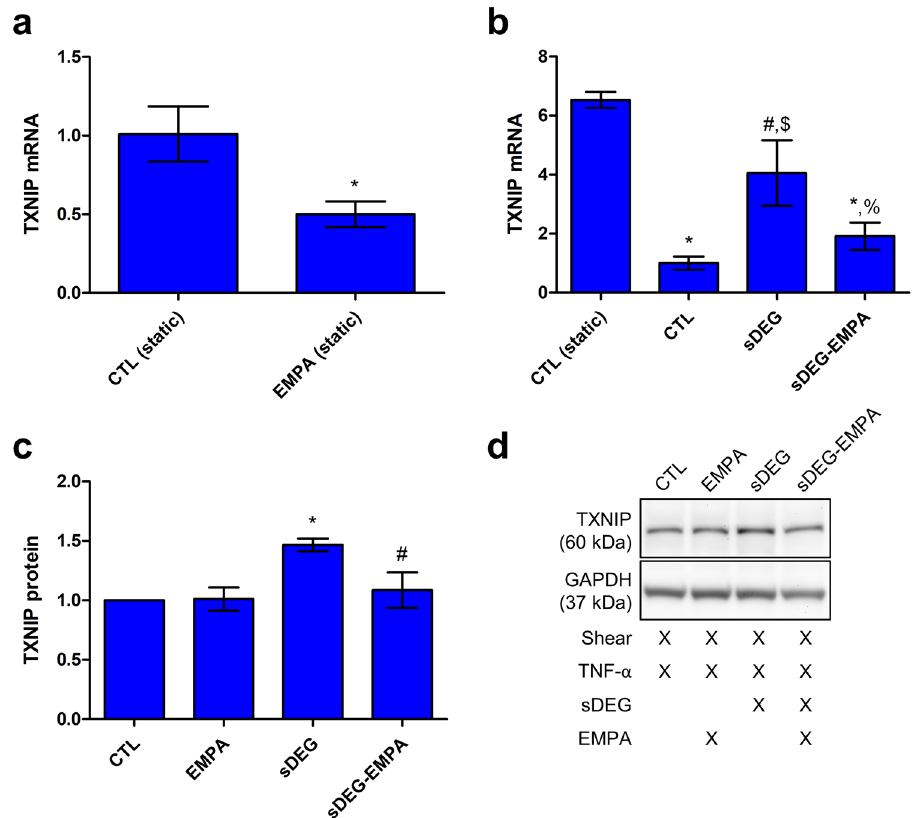
Figure 4. TXNIP mRNA expression from transcriptome analysis and protein expression in static and shear culture. ( a ) EMPA significantly reduced TXNIP mRNA levels after 6 h of static culture (EMPA vs CTL *p < 0.05) (conditions in triplicates). ( b ) TXNIP mRNA level is differently regulated by shear, sustained HS degradation and EMPA after 24 h. Shear downregulated TXNIP mRNA compared to the static control (CTL vs CTL (Static) *p < 0.001) while sustained degradation partly abolished shear-induced downregulation (sDEG vs CTL # p < 0.01, sDEG vs CTL (Static) $ p < 0.01) in TNF-α stimulated ECs. EMPA treatment restored the shear-induced downregulation compared to sDEG (sDEG-EMPA vs sDEG % p < 0.05, sDEG-EMPA vs CTL (Static) *p < 0.001) (conditions in triplicates). ( c ) TXNIP protein expression levels in shear culture are increased under degradation compared to the control (sDEG vs CTL *p < 0.01) in TNF-α stimulated ECs. EMPA reduced the expression under degradation (sDEG-EMPA vs sDEG # p < 0.01), normalizing the expression compared to the control. ( d ) Representative bands and culture condition details. Full-length blots can be found in the Supplementary Fig.